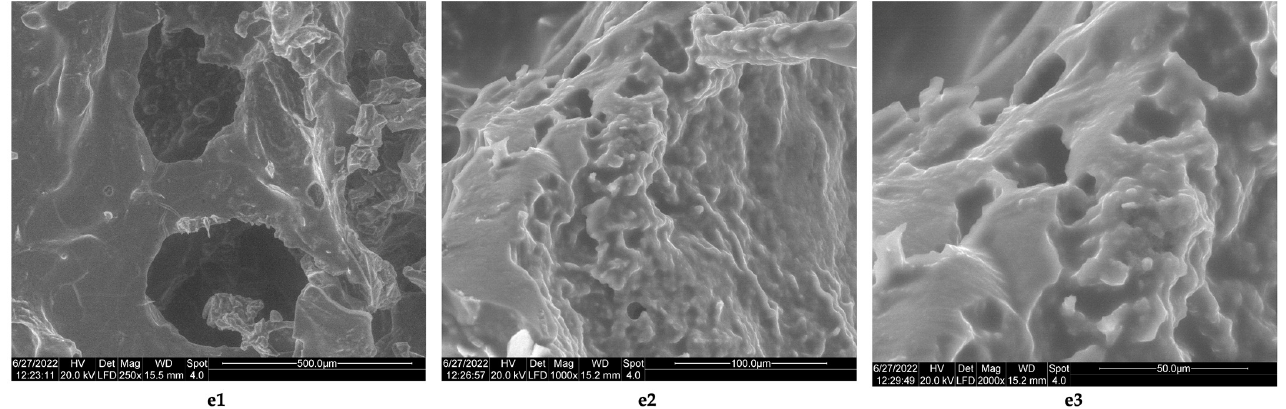
Figure 9. Morphology of sponge composite biomaterial obtained at collagen–chitosan–clotrimazole mass ratio of 1:1:0.1. ( e1 ) porous structure of composite biomaterial, with pores diameter under 500 microns (magnification 250×); ( e2 ) details regarding inhomogeneity of internal wall struc- tures and presence of interconnected pores, with diameters under 100 μ m (magnification 1000×); ( e3 ) composite biomaterial with pores diameter under 50 μ m (magnification 2000×).